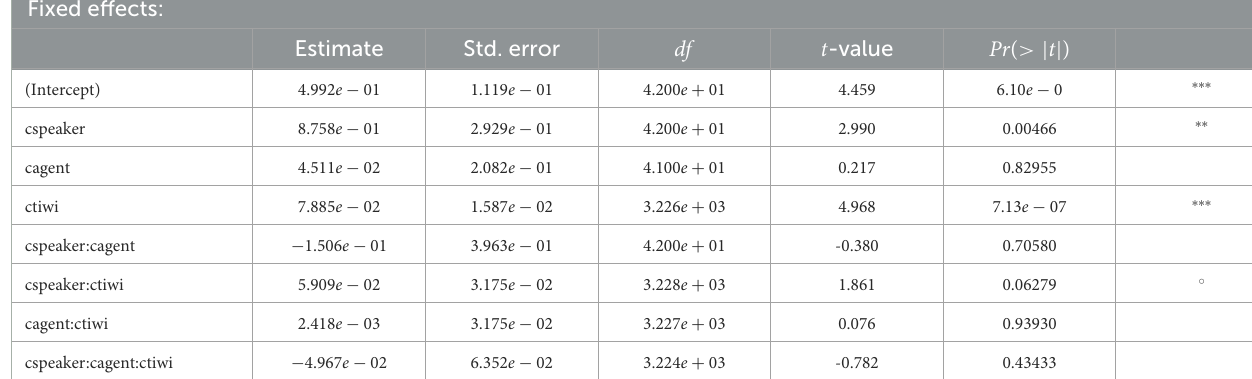
TABLE 2 Coefficients, SE s, df s, t -values, and p -values for the optimal model of logratios of target fixations for the NP2 time window in Experiment